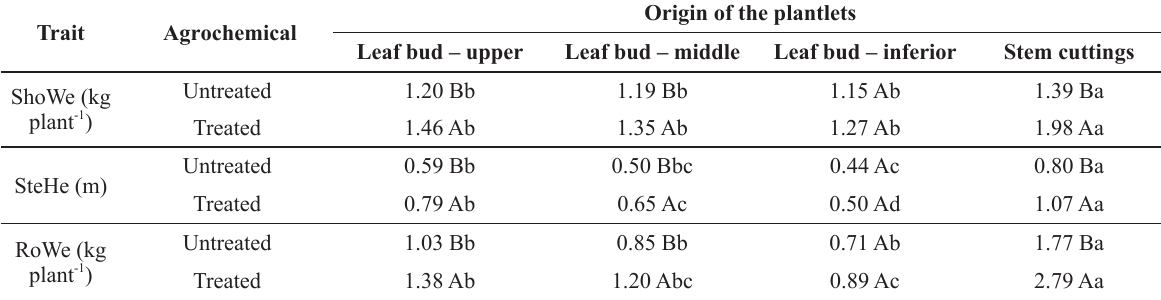
Decomposition of the interaction between origin of the plantlets (from stem cuttings or leaf buds extracted from the upper, middle or inferior position of the mother plants) and treatment with agrochemicals, for three agronomic traits. Trait